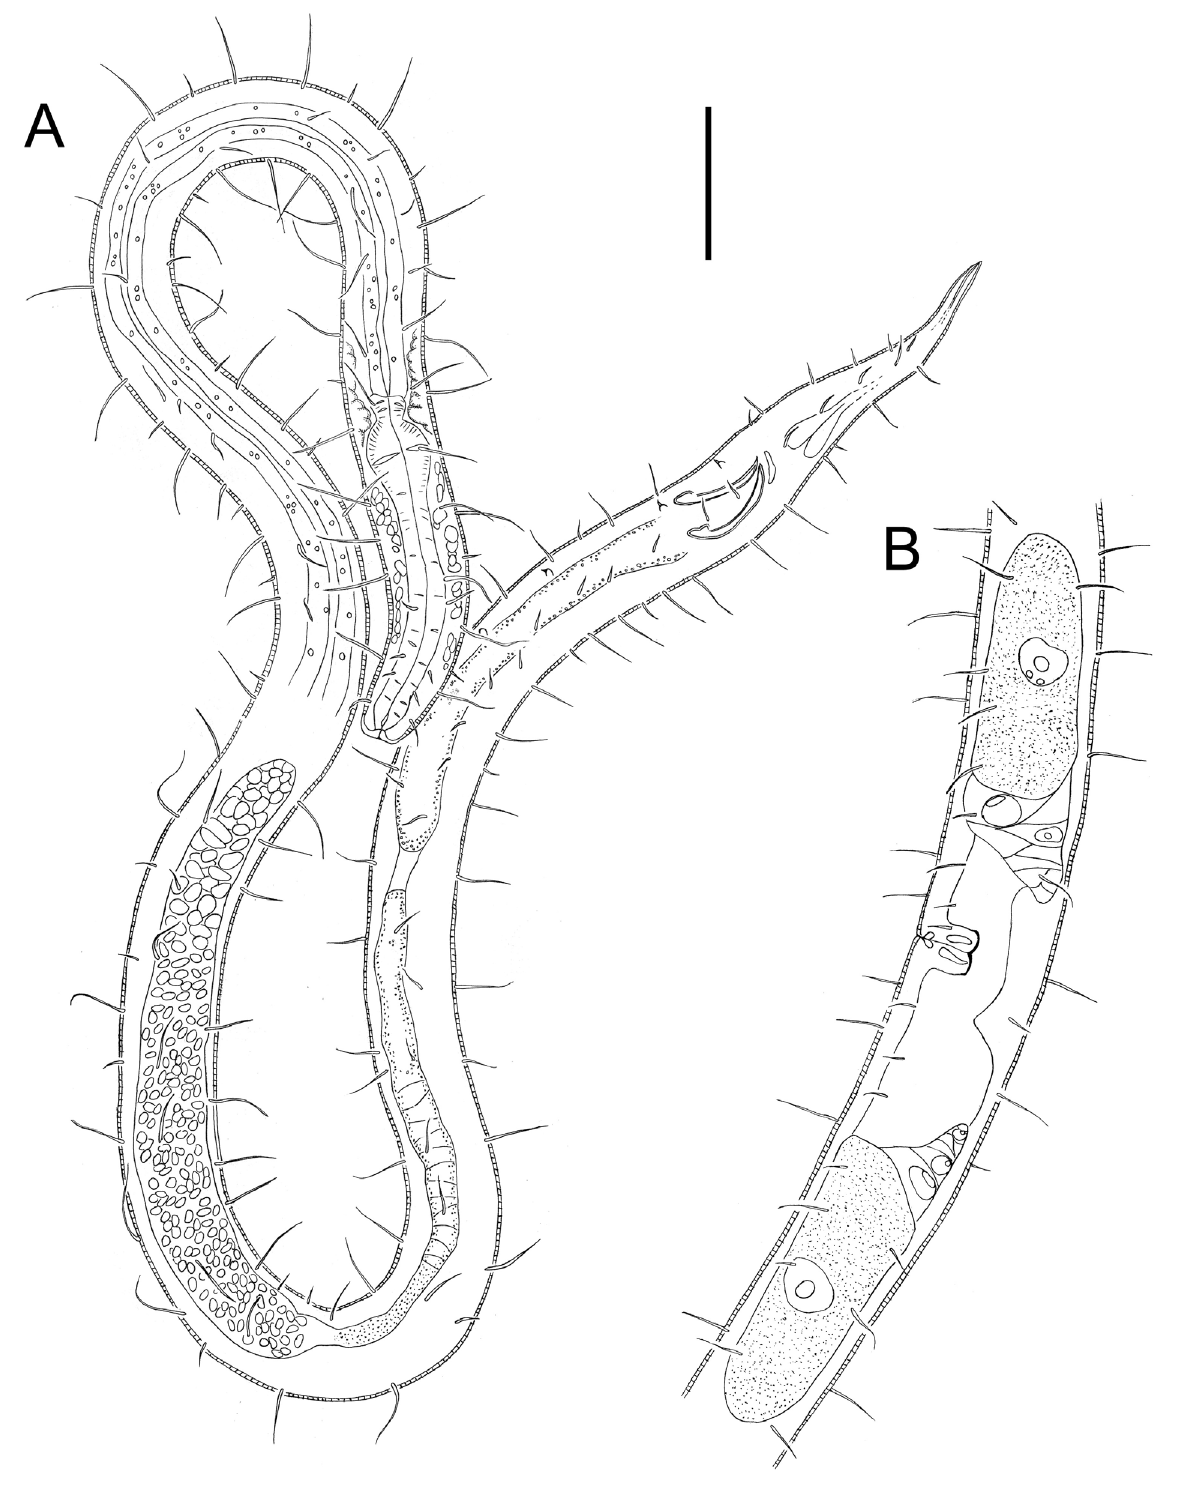
Fig. 5. Stygodesmodora confusa sp. nov. A . Entire male. B . Female reproductive system. Scale bar: A = 50 µ m, B = 36 µ